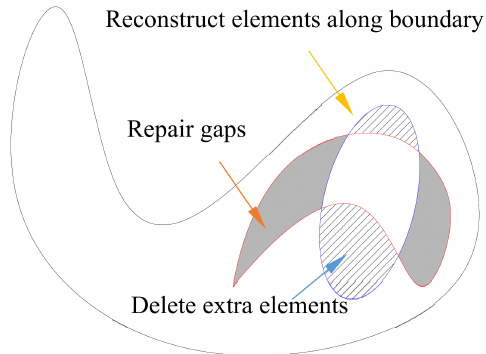
Figure 5. Measurement for refinement in the traditional method when the hole is changed.